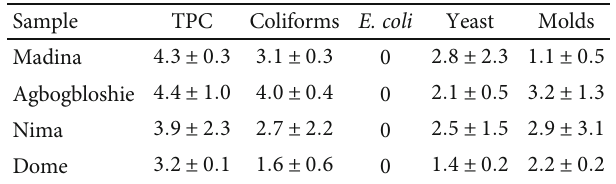
Table 4: Microbial population (log from four markets. Sample TPC Coliforms E. coli